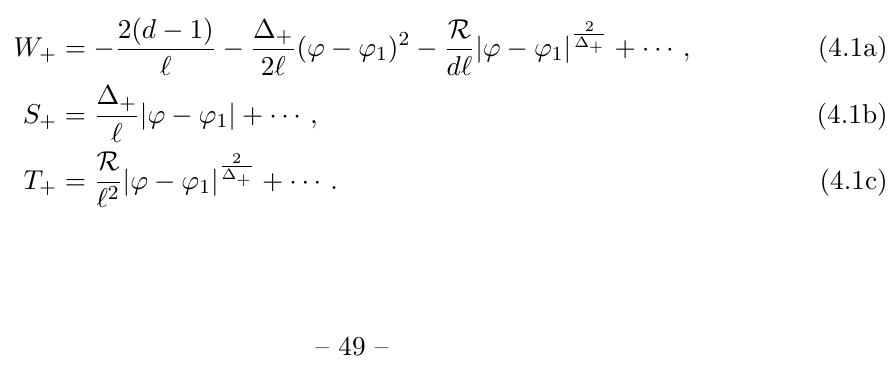
(the green region) and 1 , 1